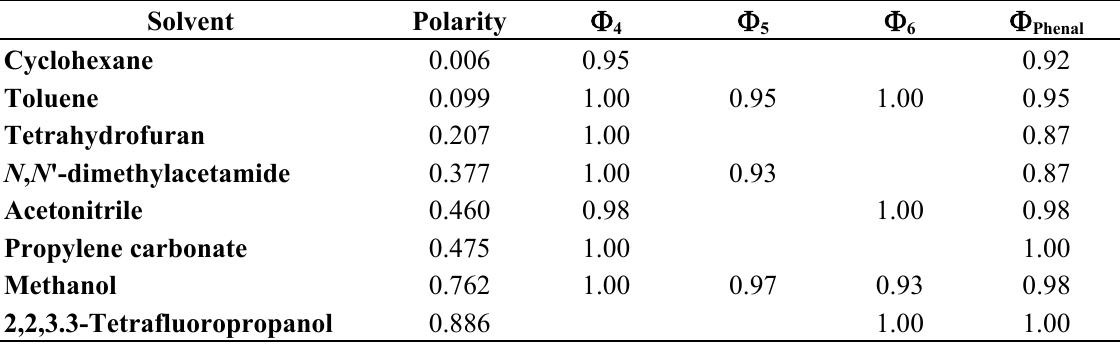
Table 5. Singlet oxygen quantum yield (  phenalenone ( Phenal ) in different solvents and varied